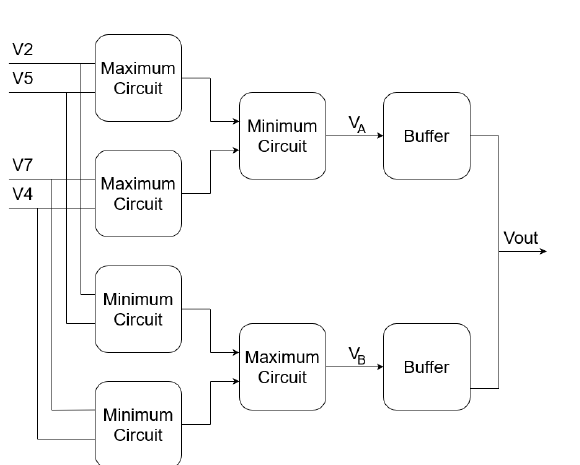
Figure 5. Block diagram of defective pixel correction circuit.